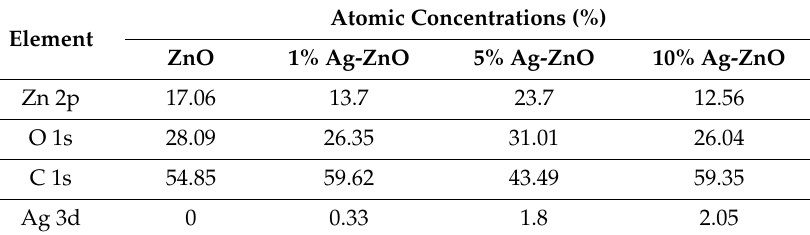
Figure 4. XPS survey spectra of ( a ) ZnO and ( b ) 10% Ag-ZnO powder samples. Table 1. Atomic concentrations calculated from the XPS measurements.